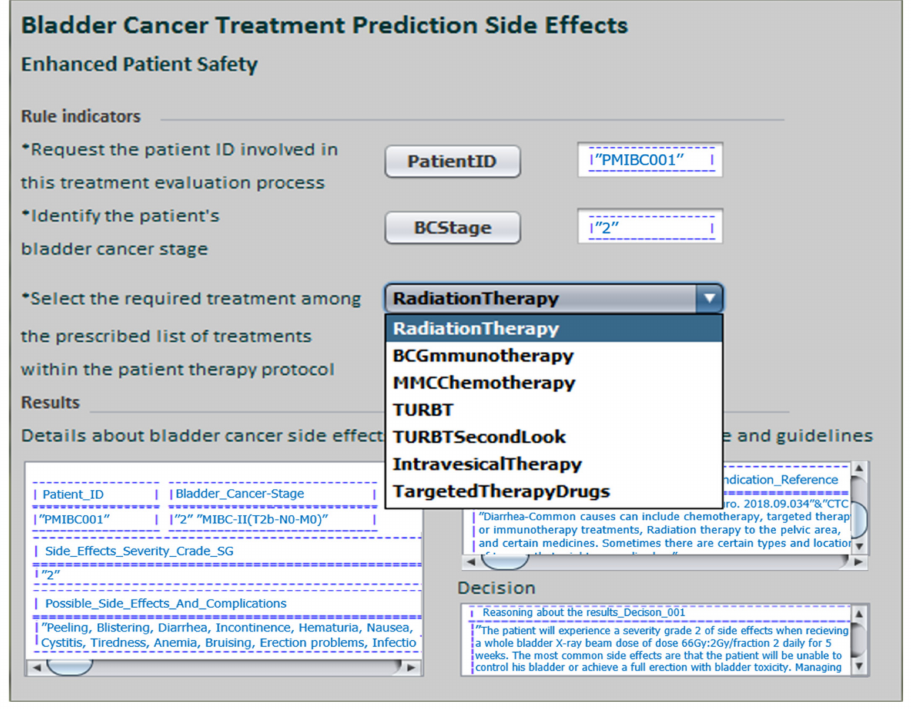
Figure 11. Results displayed on the bladder cancer treatment side effects prediction API